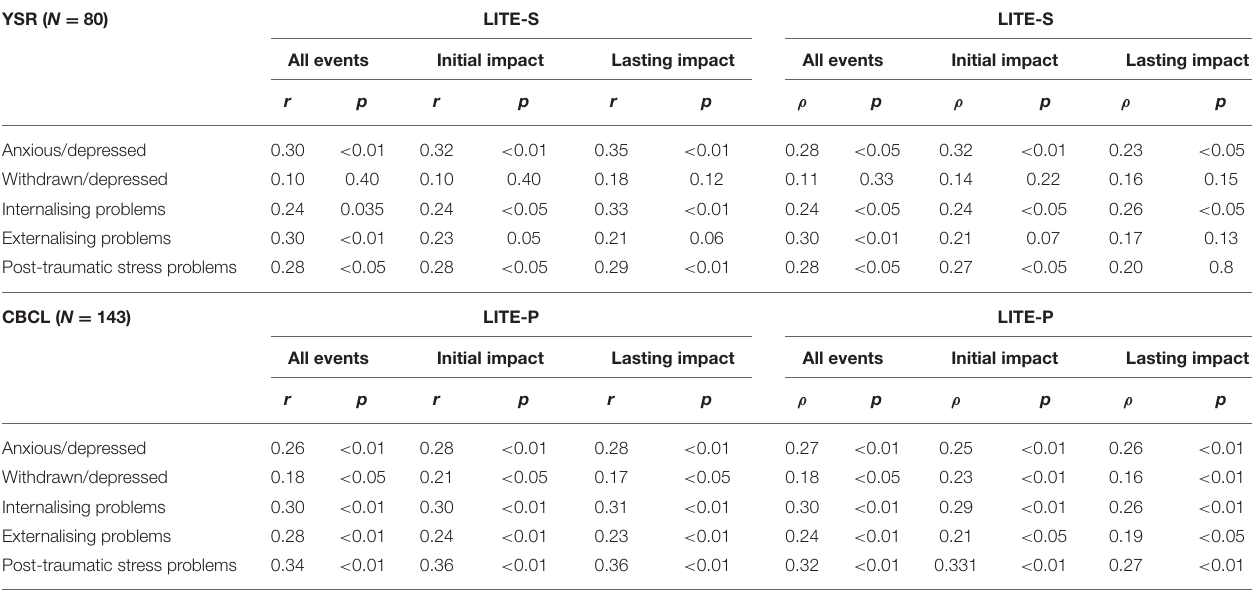
TABLE 9 | Correlations between the LITE scales and measures of emotional and behavioural problems. YSR ( N = 80) LITE-S LITE-S All events Lasting impact All